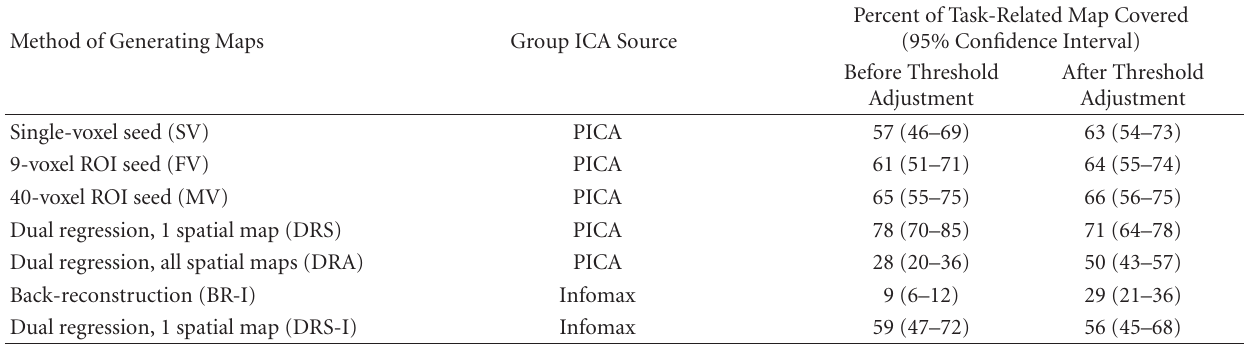
Table 4: Experiment 3: mean percentages of thresholded task-related GLM maps that are covered by the thresholded subject-specific FC maps generated with each method below. The right-most column gives percentages after adjusting the z-score used to threshold the FC maps so that number of false positives equals number of false negatives. For the BR-I method, adjusting the threshold helped to compensate for what might have been an overly conservative thresholding, but the results for this method were still significantly lower those than for the other six methods